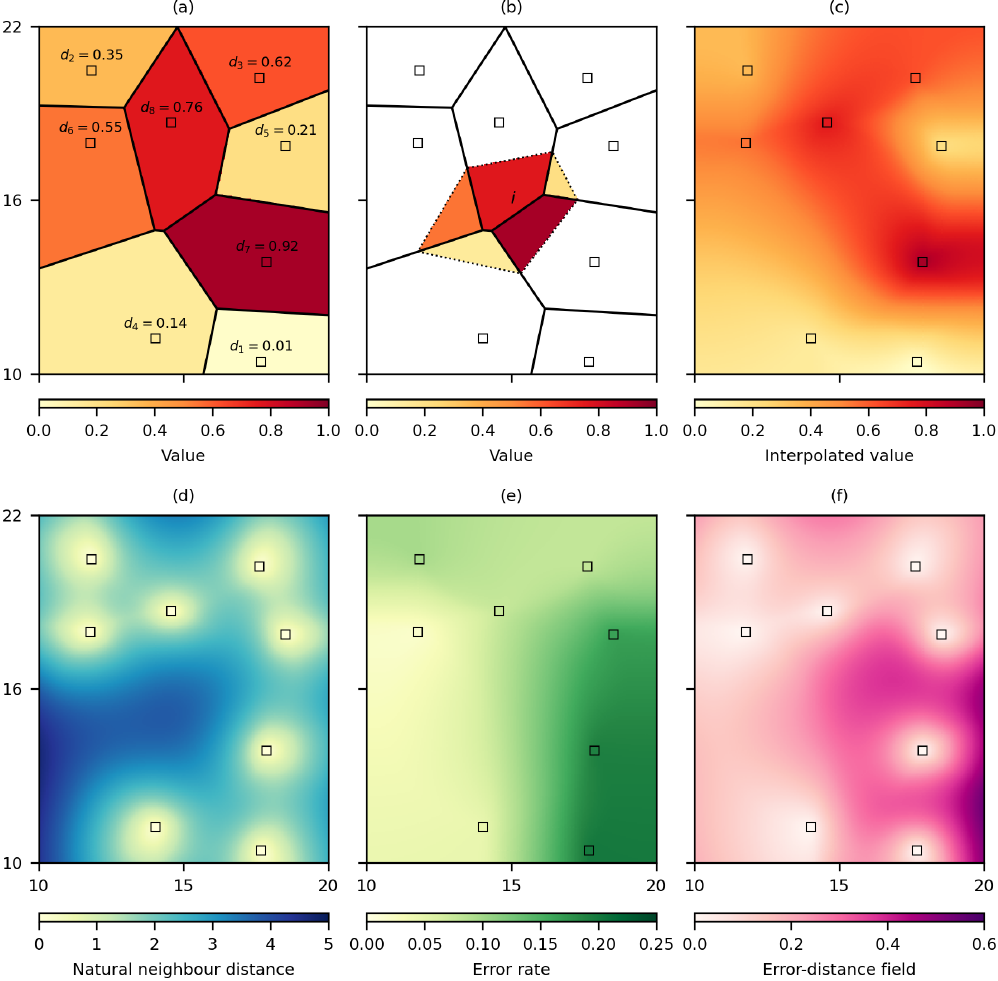
Figure 4. A hypothetical example to illustrate discrete natural neighbour interpolation with a cross-validation error-distance field. Beginning with a set of data cells d i , shown as squares, a grid of cells is defined and (a) each cell is given the value of the nearest data cell d , (b) for any interpolation cell i the interpolated value is the mean of cell values that are as close or closer to the interpolation cell than a data cell, which (c) when repeated for all grid cells produces a natural neighbour interpolation. Natural neighbour interpolation is also used to interpolate (d) the distances to the data cells and (e) the cross-validated error rate of each data cell. The interpolation uncertainty is then (f) the cross-validation error distance field that is the product of the natural neighbour distances and error rates (adapted from Etherington, 2020, https://creativecommons.org/licenses/by/4.0/, last access: 16 February